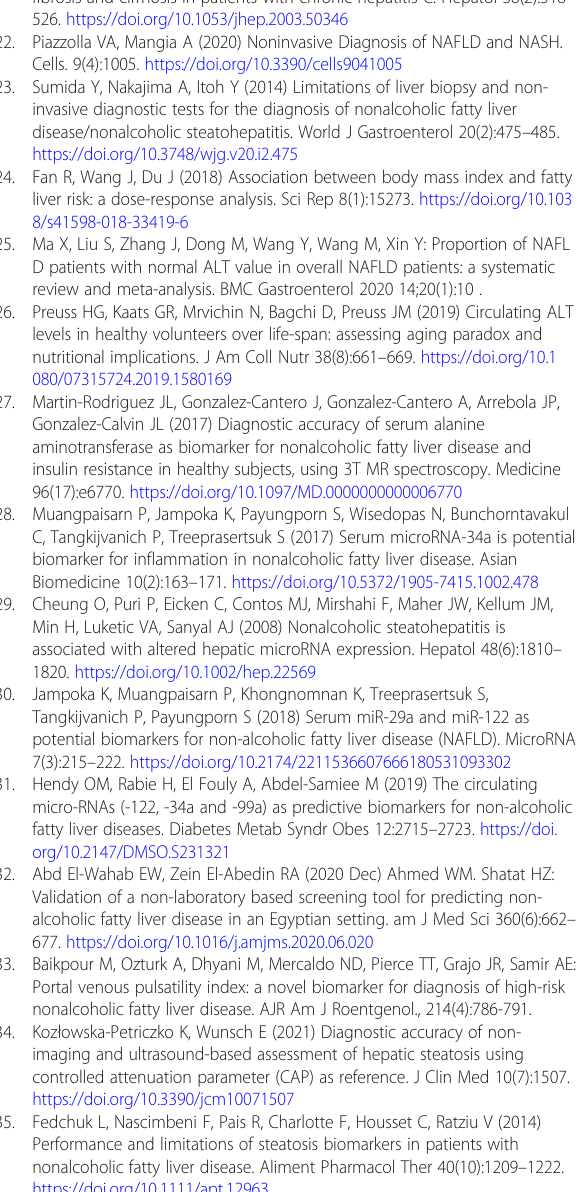
fibrosis and cirrhosis in patients with chronic hepatitis C. Hepatol 38(2):518 – 526.